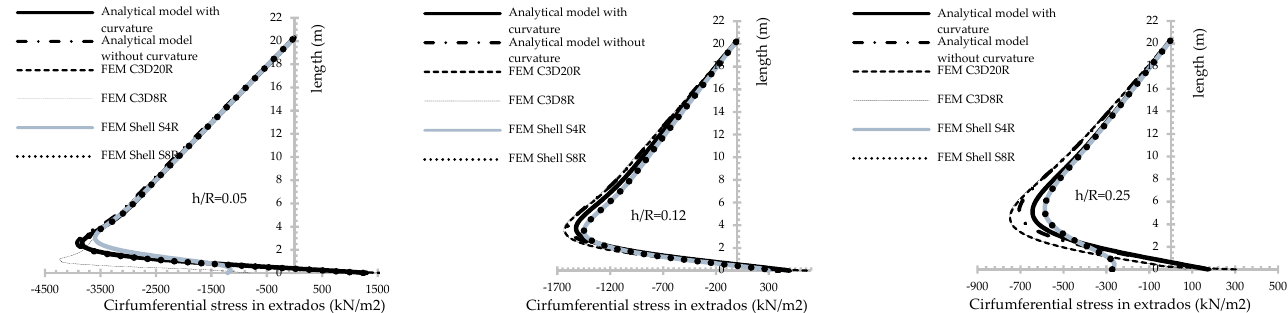
Figure 8. Circumferential stress in extrados for thin, medium and thick shells, considering different models.